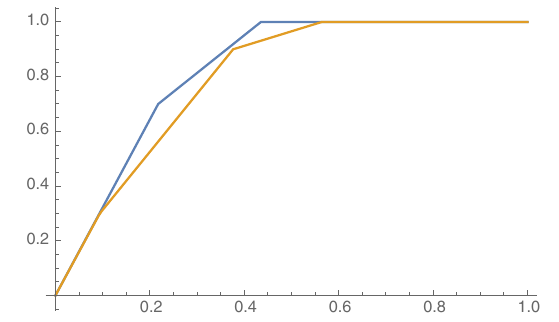
FIG. 5. The thermal Lorenz curves signify the possibility of state transition (D1) by a thermal